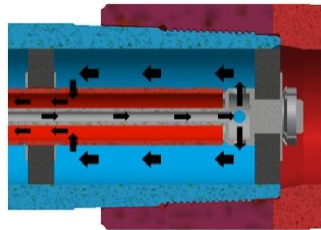
Figure 2. Status of hot assembly completion.